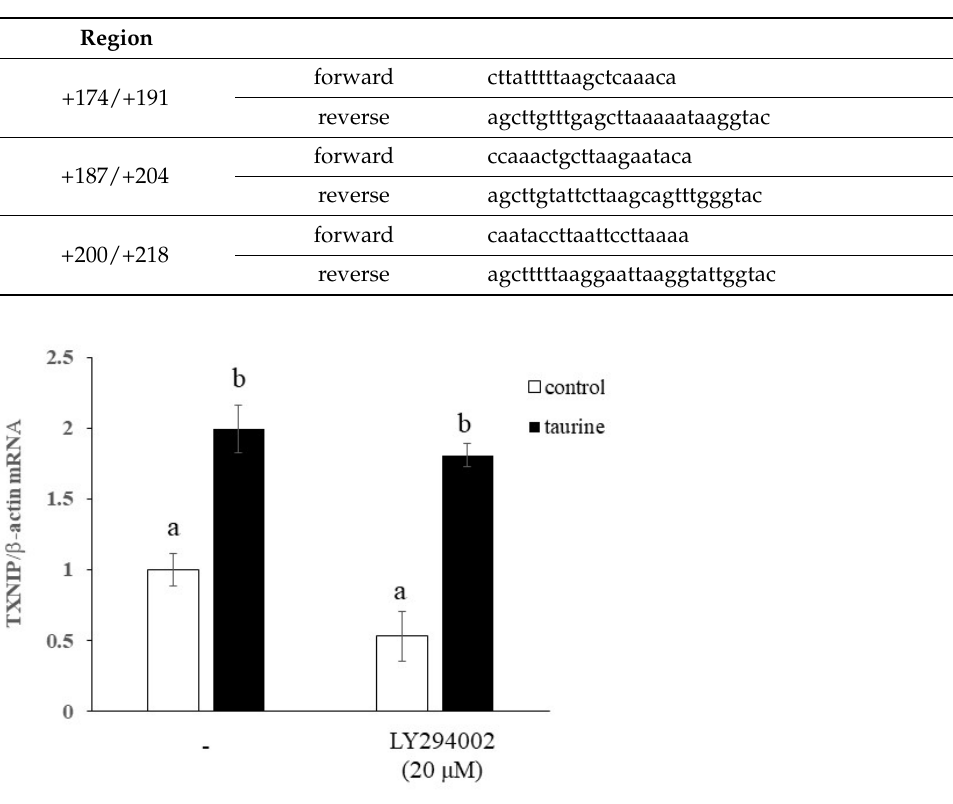
Figure A1. Effect of the PI3K inhibitor on taurine-induced increase in TXNIP mRNA in human hepatic HepG2 cells. HepG2 cells were pretreated with 20 µ M LY294002 for 2 h and then cultured in medium containing 100 mM of taurine and the inhibitor. After 48 h, RNA was extracted and used for real-time PCR. The results are expressed as relative values, with the control value without LY294002 as 1. Each value is the mean ± S.E. ( n = 4), and the ab values indicated by different characters are significantly different from each other and the ab values indicated by the same characters are not significantly different (Tukey’s test; p < 0.05).